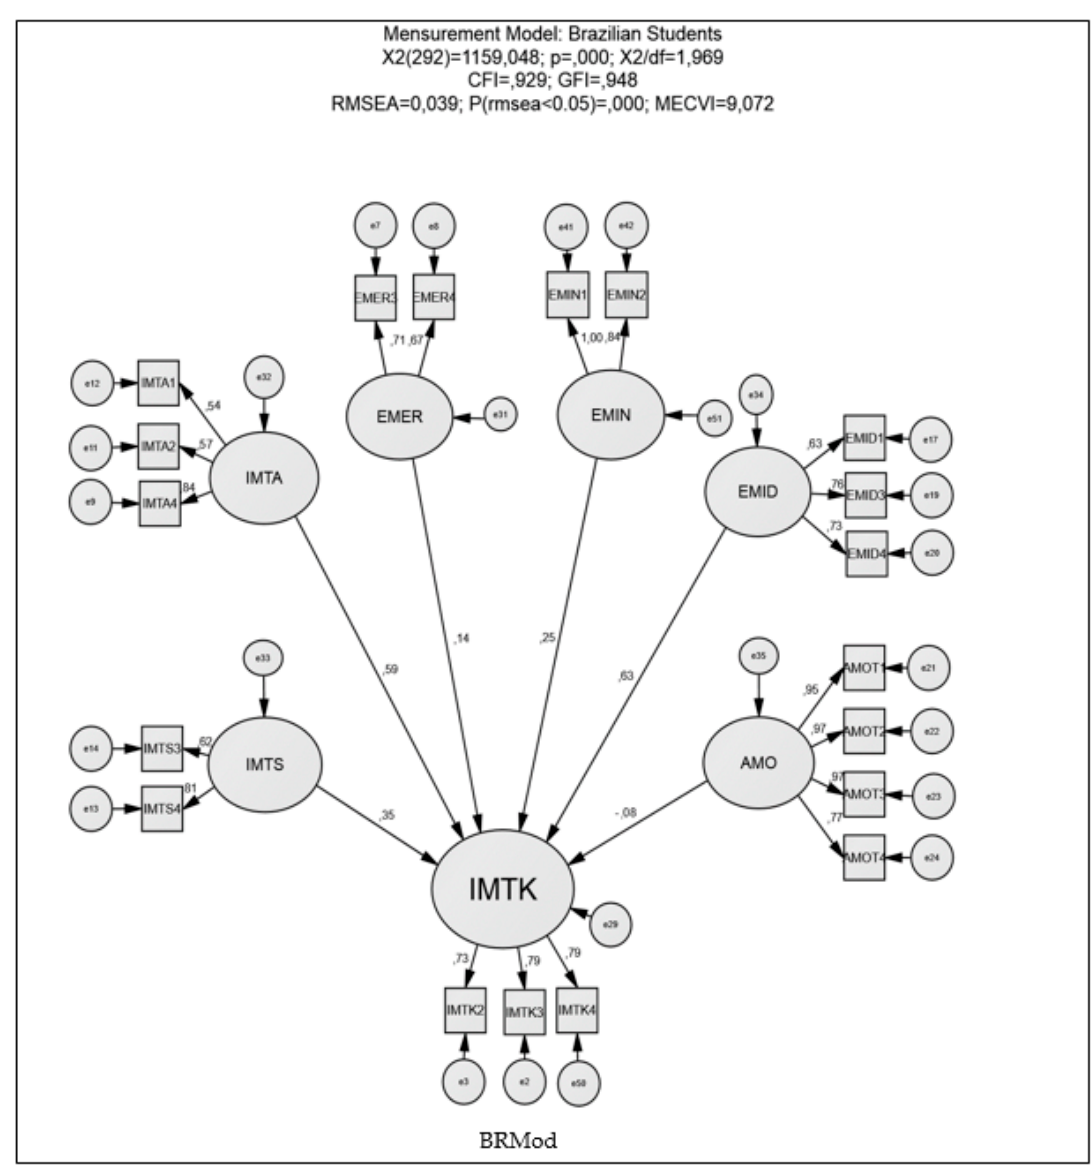
Figure 3. Structural Model–Brazil.